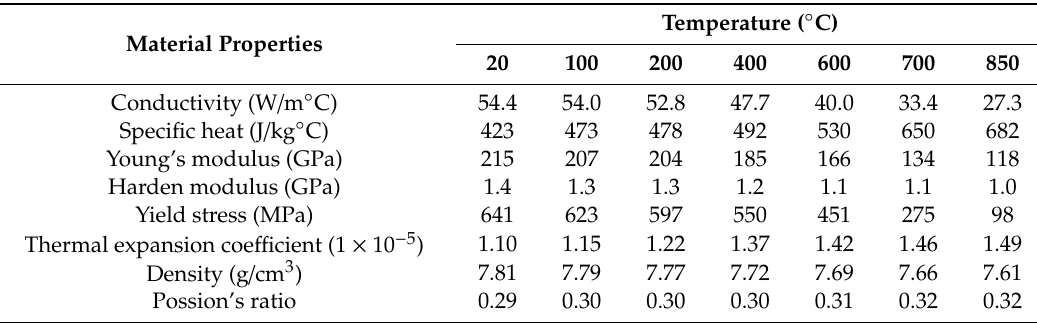
Table 1. Material properties of α —ferrite.